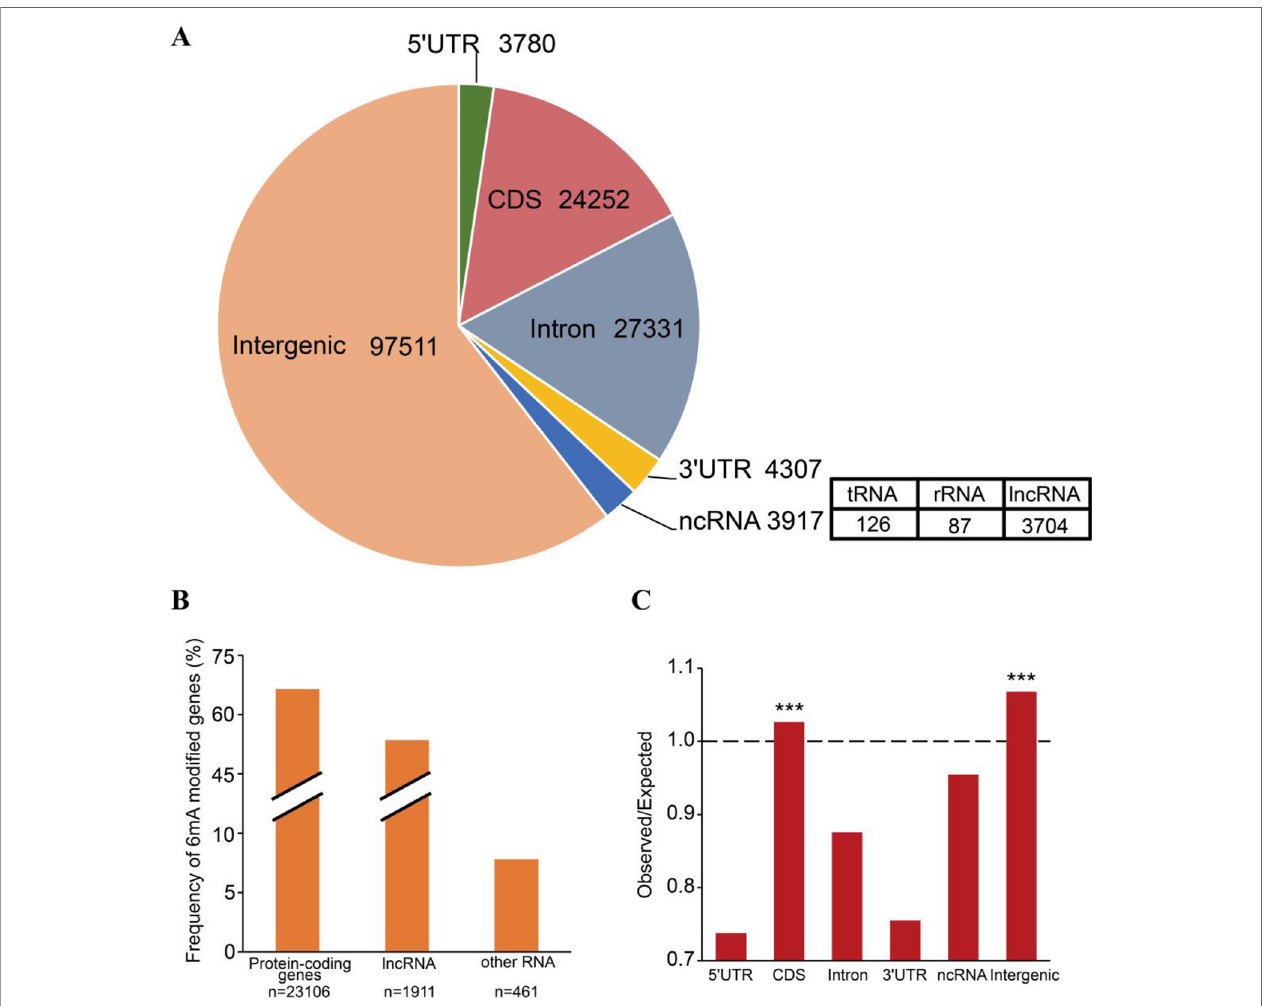
FIGURE 3 | Distribution of N 6 -methyladenine ( 6mA ) in genomic features of Fragaria vesca v1.0 genome. (A) Number of 6mA modi fi cation sites distributed in 5 ′ UTR, coding sequence ( CDS ), 3 ′ UTR, and intronic regions of protein-coding genes, non-coding (nc)RNA, and intergenic regions. ncRNA included tRNA, rRNA, and lncRNA. (B) The frequency of 6mA-methylated genes in protein-coding RNA, lncRNA, and other RNA that included tRNA and rRNA. (C) Comparison of observed versus expected distributions of 6mA modi fi cations in each functional element. The expected distribution of methylation sites was calculated by the total number of adenines in each category multiplied by the genome-wide 6mA density. The signi fi cant difference between the observed and expected numbers of methylation sites was determined using the binomial test, *** p <